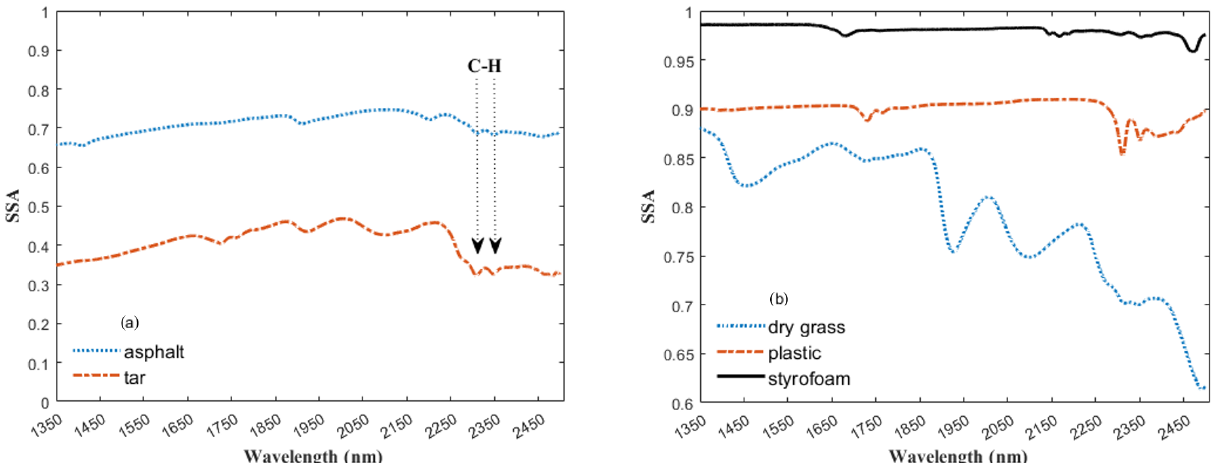
Figure 7. Panels (a) and (b) show the spectra for non-mineral materials common in urban settings. The arrows in panel (a) point to a doublet arising from C–H bonds in asphalt and tar. Spectra in (b) are for other materials that were visually identified in the samples whose absorption features may lead to poorer model fits. All spectra for both figures are offset for